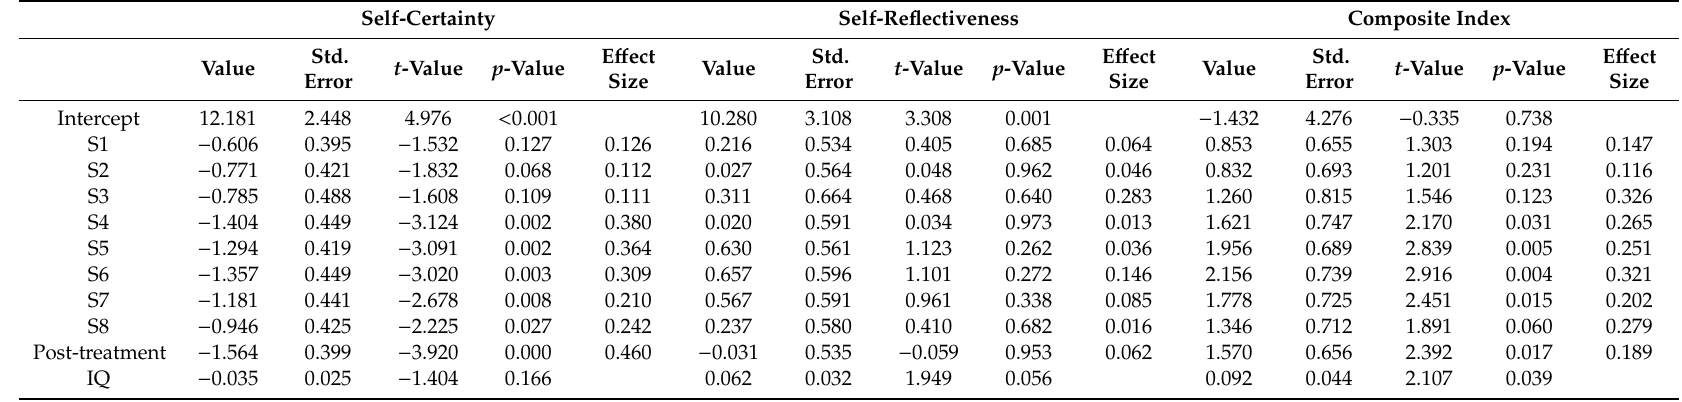
Table 2. E ff ects of each session and at the post-treatment in self-certainty, self-reflectiveness, and the Composite Index and influence of intelligence quotient (IQ). Self-Certainty Self-Reflectiveness Composite